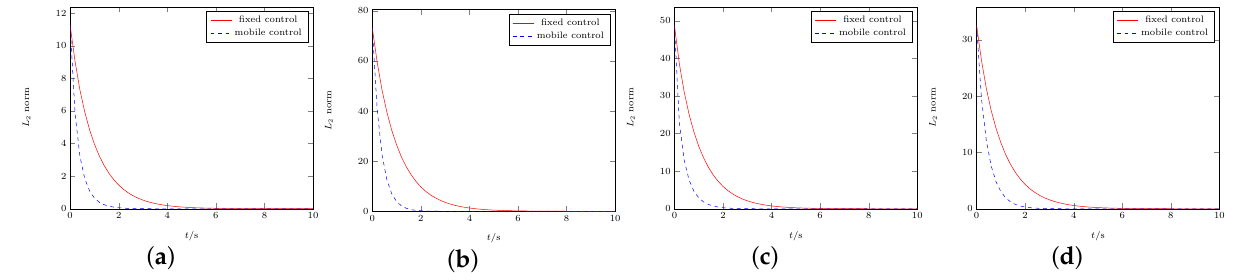
Figure 7. The L 2 norms of estimation error e ( t ) under fixed control and mobile control. ( a ) L 2 norm of e 1 ( t ) . ( b ) L 2 norm of e 2 ( t ) . ( c ) L 2 norm of e 3 ( t ) . ( d ) L 2 norm of e 4 ( t )